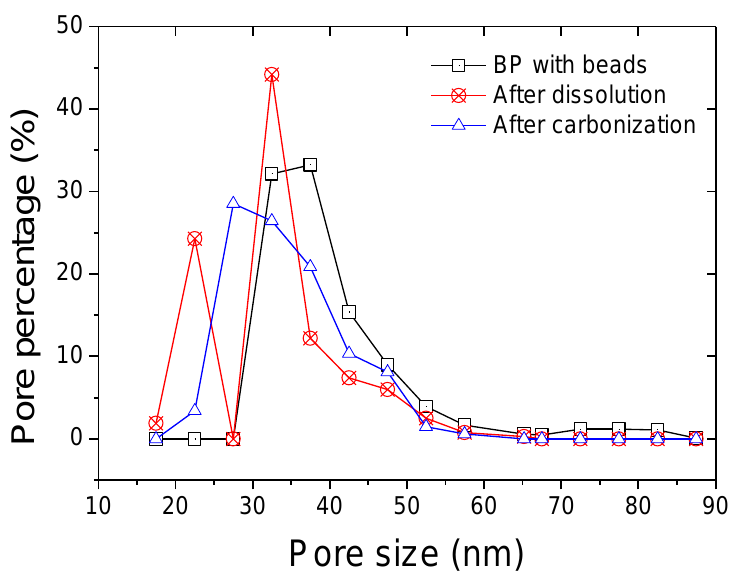
Figure 4. Pore size distribution of the composite membranes determined by perm-porometry.